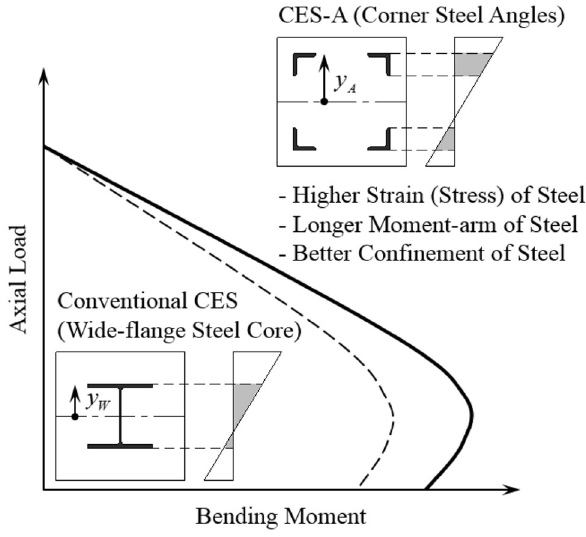
Fig. 1 Advantages of concrete-encased steel angle (CES-A) section (Kim et al.